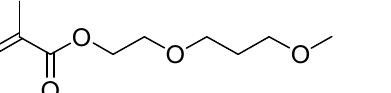
Figure 1. Structure formula of 2-(methoxyethoxy)ethyl methacrylate (DMEEMA).